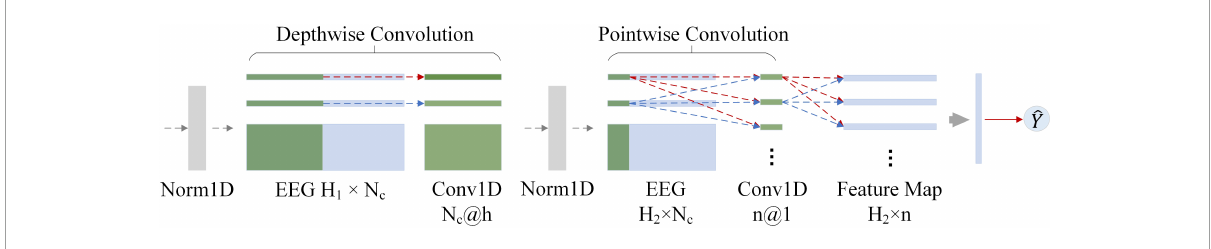
FIGURE6 Separable convolutional neural network (SepCNN) structure. H 1 is the length of the input data, N c is the number of channels, h is the size of the depthwise convolution kernel, H 2 is the input data length of the second layer, and n is the number of pointwise